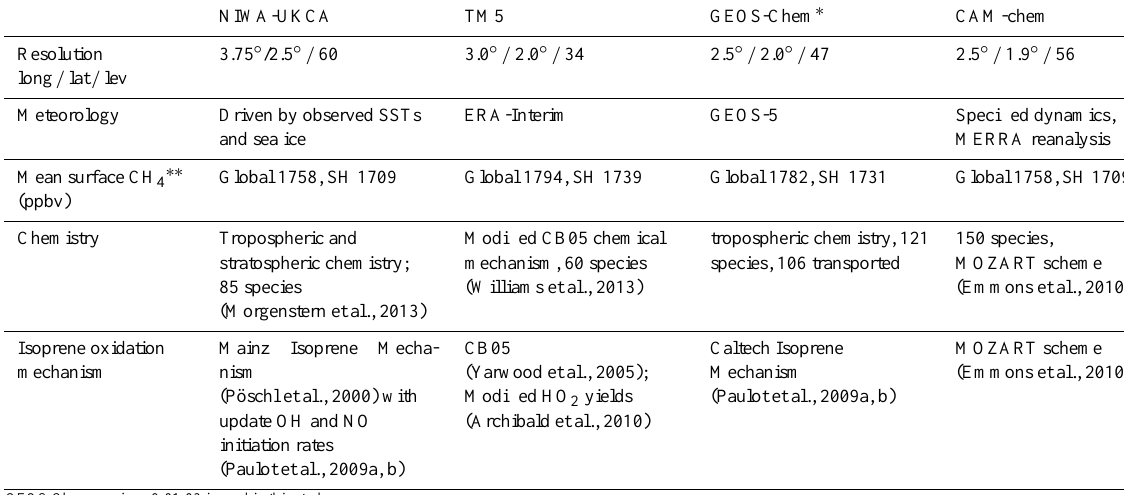
Table 2. Summary of model